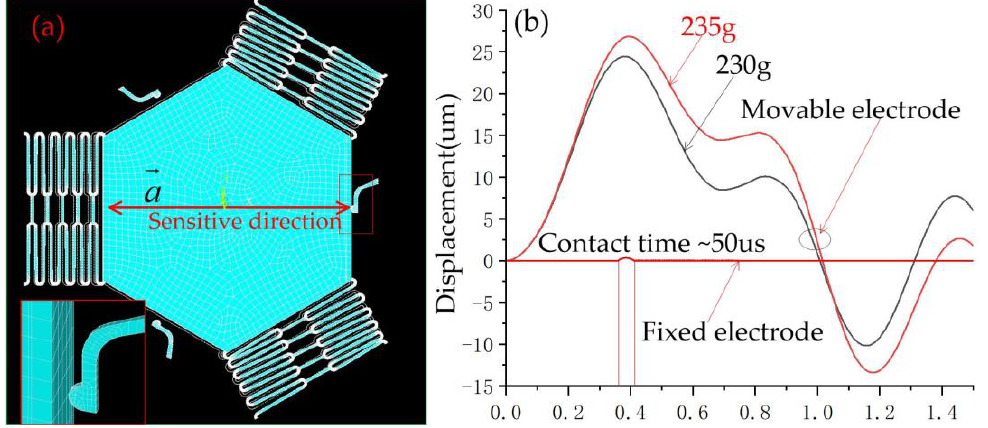
Figure 5. ( a ) Schematic diagram of movable electrode in contact with fixed electrode in a sensitive direction; ( b ) the dynamic contact process curves of movable and fixed electrodes in a sensitive direction.